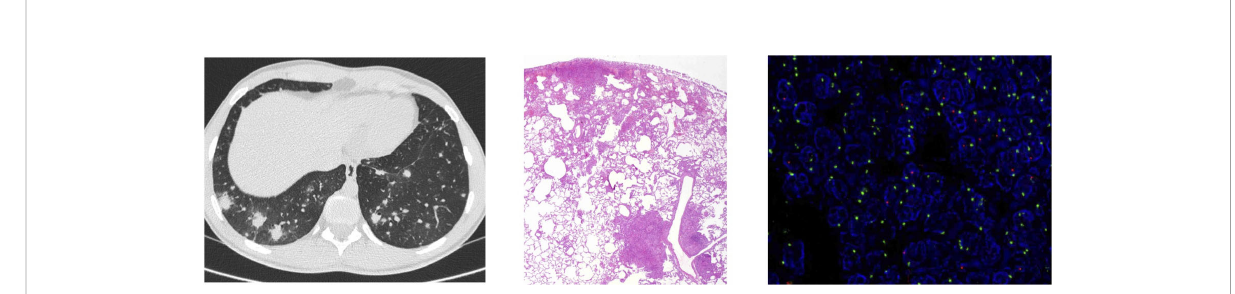
FIGURE 2 Study of lung lesions of case 1. First image computed tomography (CT) scan showing multiple lung nodules. Second image wedge luyng biopsy demonstrated a non-necrotizing granulomatous in fl ammation concentrated bronchovasculocentrically and paraseptally [hematoxylin and eosin (H&E), 2x]. Third image fl uorescencein-situ hybridization (FISH) using locus speci fi c indenti fi er (LSI) SRY. In the lymphocytic in fi ltrates, up to 27% of the nuclei showed a green dot (CEP X) and a red dot (SRY), and 73% of the nuclei showed two green dots (CEP X), thus indicating that the majority of the lymphocytic in fi ltrate corresponded to the female